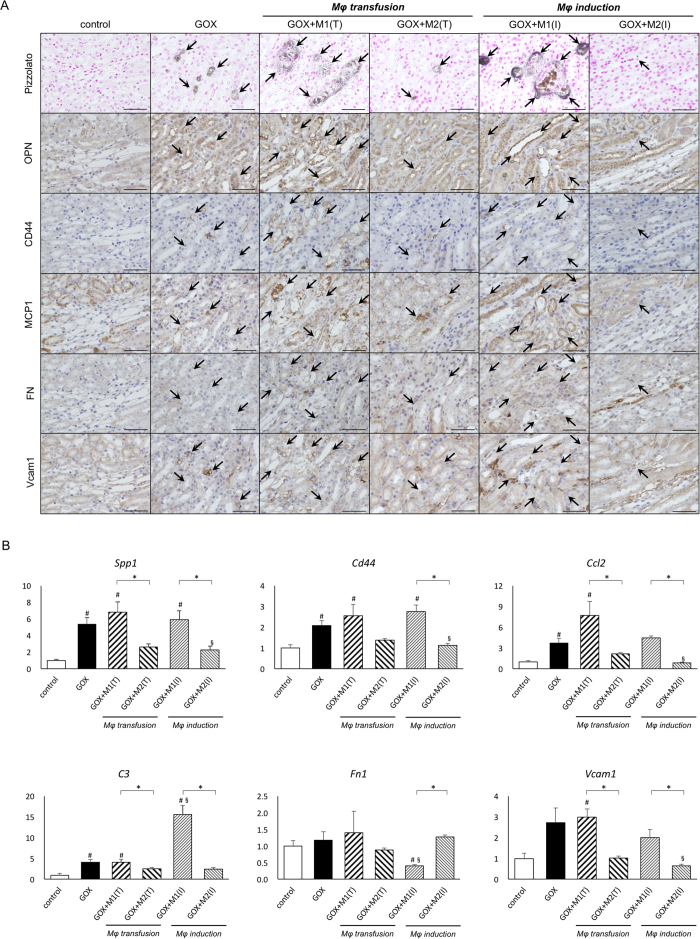
Evaluation of crystal-related and adherence-related gene expressions.(A) Immunohistochemical distribution of gene expression in mouse kidneys harvested at d 6. Pizzolato staining indicated calcium oxalate (CaOx) crystal deposits (arrows). OPN, osteopontin; MCP-1, monocyte chemoattractant protein 1; FN, fibronectin; Vcam1, vascular cell adhesion molecule 1. Scale bar = 50 μm. (B) The expression of genes was determined by quantitative reverse transcription polymerase chain reaction (qRT-PCR) using TaqMan assays. Control values represent the average of the data for the control group. Data are presented as means ± standard errors. N = 6 for each group. *Indicates significant differences between the M1 and M2Mφ groups in the same treatment at p < 0.05; #indicates significant differences compared with the control group at p < 0.05; §indicates significant differences compared with the glyoxylate (GOX)-treated group. Spp1, secreted phosphoprotein 1; Ccl2, chemokine (C-C motif) ligand 2; Fn1, fibronectin 1; Vcam1, vascular cell adhesion molecule 1. M1(T) and M2(T) indicate transfusion, whereas M1(I) and M2(I) indicate induction treatment of each macrophage.